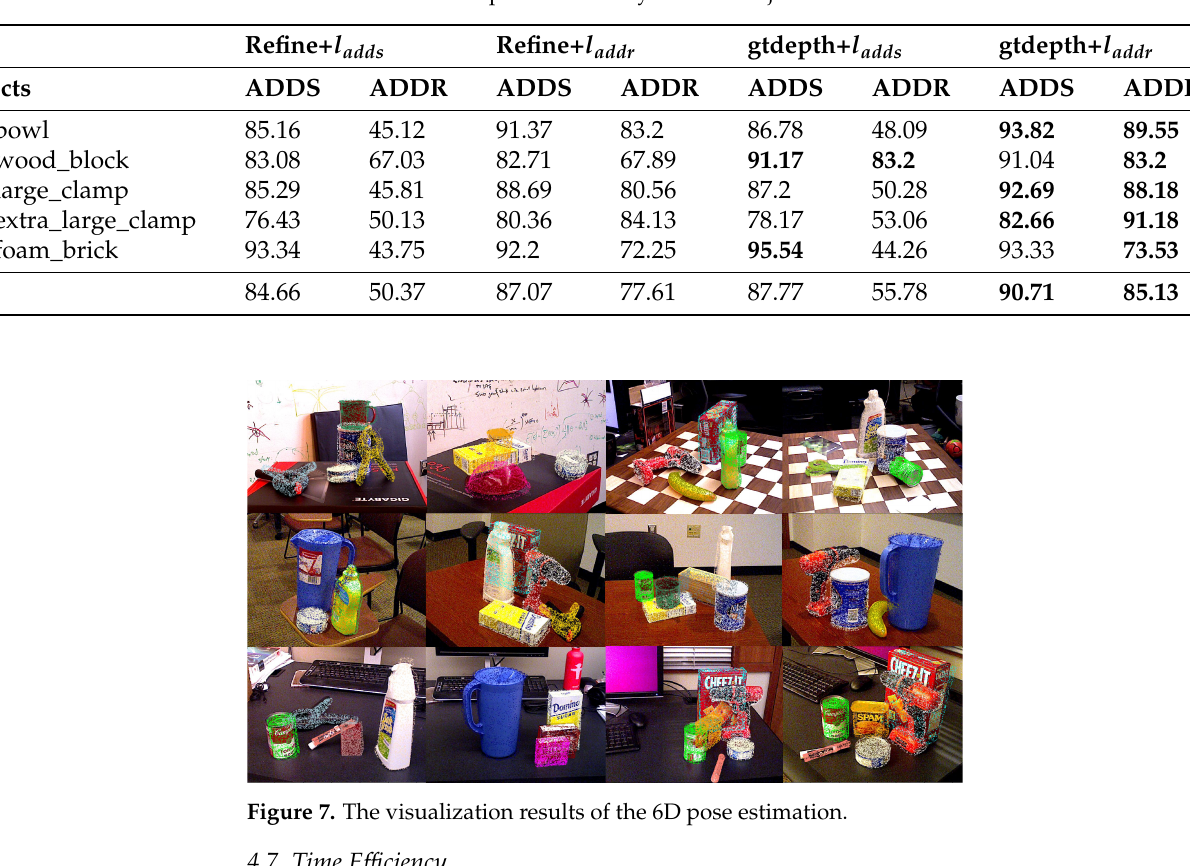
Table 5. Contrast Experiments on Symmetric Object Loss.